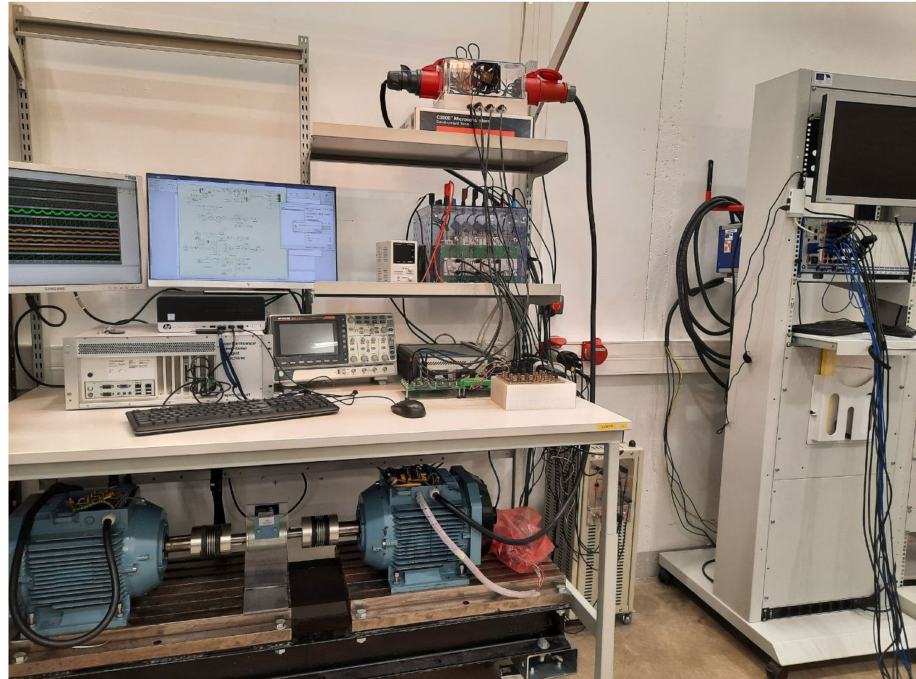
Figure 14. The experimental setup of the research laboratory drive